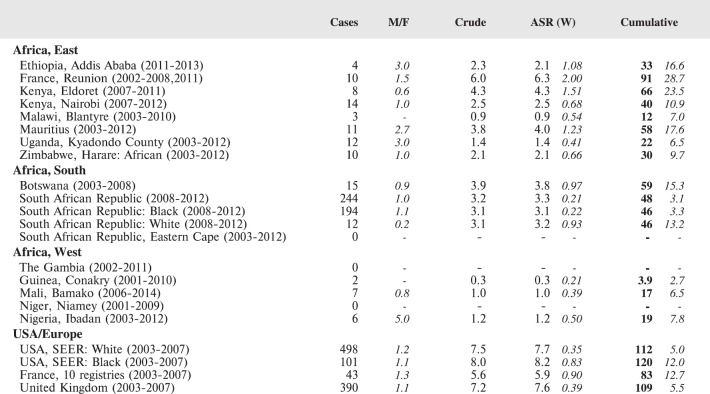
Crude, age-standardised (world) and cumulative (0–14) incidence rates (per million) and standard errors – Acute myeloid leukaemia.